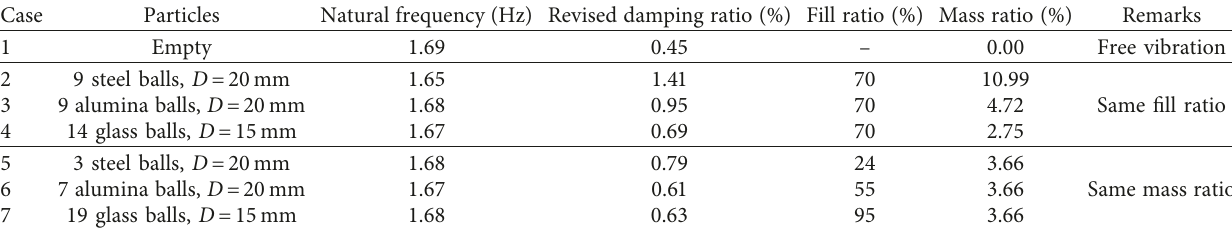
Table 2: Natural frequency and revised damping ratio of each case.